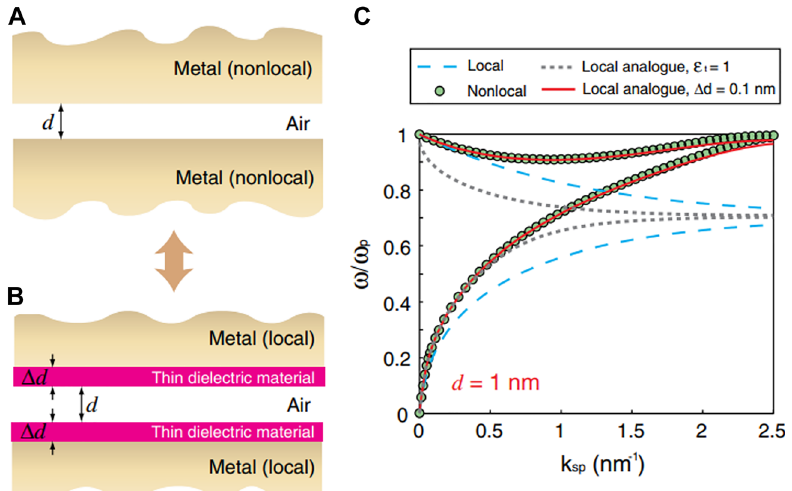
Figure 4: Nonlocal effects in a metallic